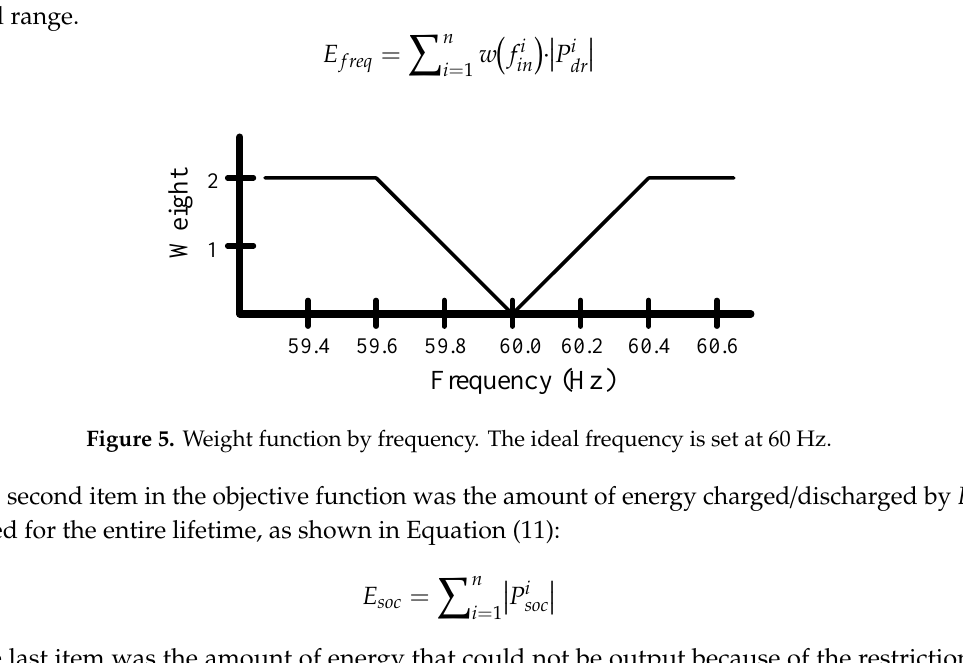
Figure 5. Weight function by frequency. The ideal frequency is set at 60 Hz.